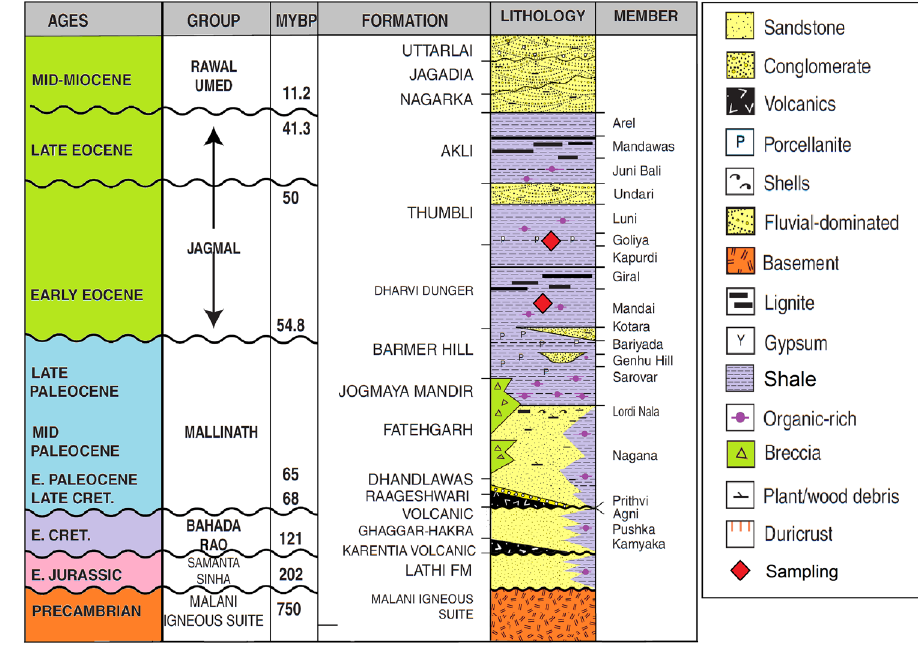
Fig. 3 Generalized stratigraphic succession in Barmer Basin, including organic-rich sedimen- tary sequence, ranging in age from Lower Jurassic to Eocene [modified after Dolson et al.